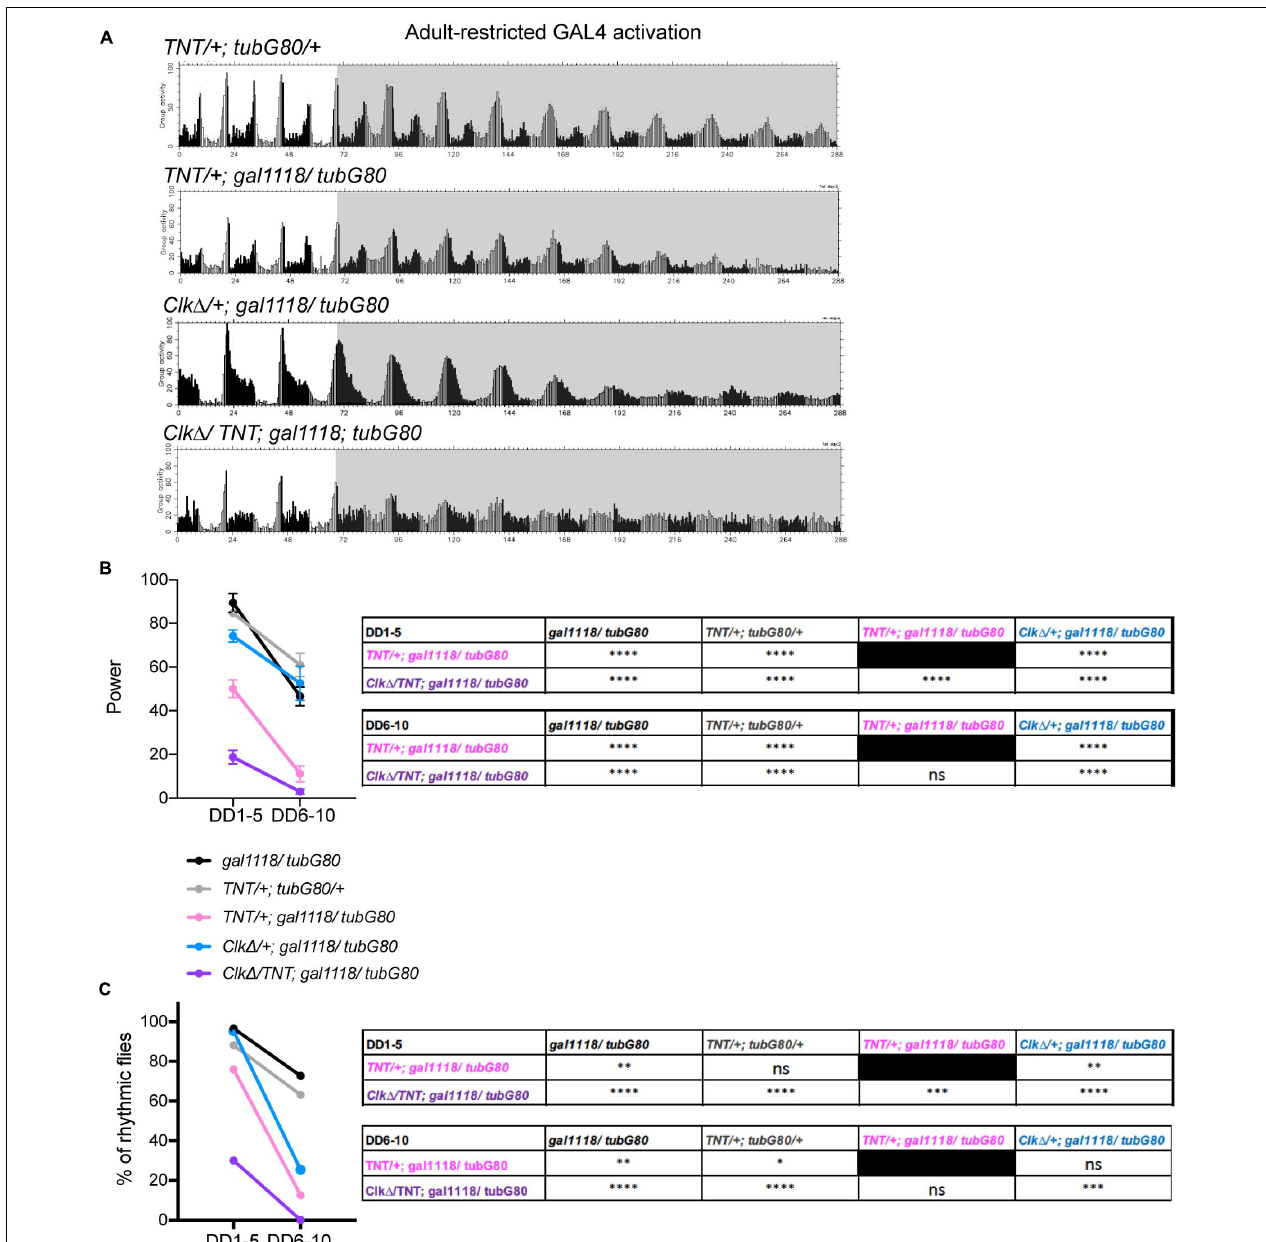
FIGURE 6 | Intact neuronal output of the M-oscillator is required for sustaining robust free-running locomotor rhythms. (A) Group average locomotor activity of the flies expressing TNT, CLK (cid:49) or TNT and CLK (cid:49) in the LNvs with the combination of gal1118 and tub-GAL80 ts during adulthood and a control group ( UAS-TNT/ + ; tub-GAL80 ts / +). The activity of another control group, gal1118 / tub-GAL80 ts , is displayed in Figure 3D . (B) Power of rhythmicity of the flies of indicated genotypes in DD1-5 and DD6-10. The unpaired t -test with Welch’s correction and Mann-Whitney U -test were used to compare two genotypes at the same time point. The tables show the statistical test results, in which groups labeled in the row are compared with those in the column. ∗∗∗∗ p < 0.0001. ns, not significant. (C) The percentage of rhythmic flies in DD1-5 and DD6-10. The genotypes are as in (B) . Results of Fisher’s exact test for pairwise comparisons are shown in the table. ∗ p < 0.05, ∗∗ p < 0.01, ∗∗∗ p < 0.001, and ∗∗∗∗ p < 0.0001. ns, not